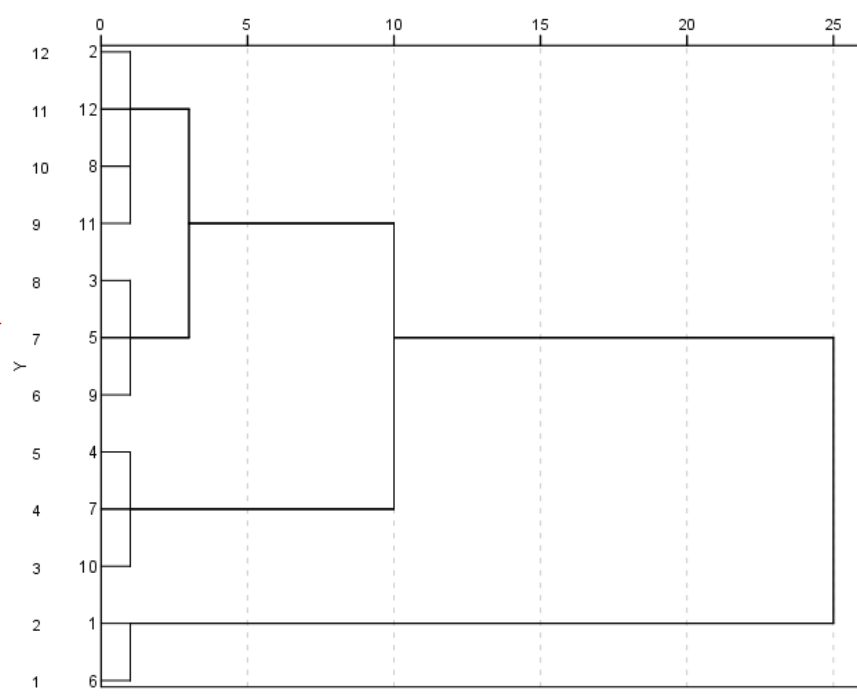
Figure 2. Cluster analysis results graph. Table 8. Time window information for each medical device demand